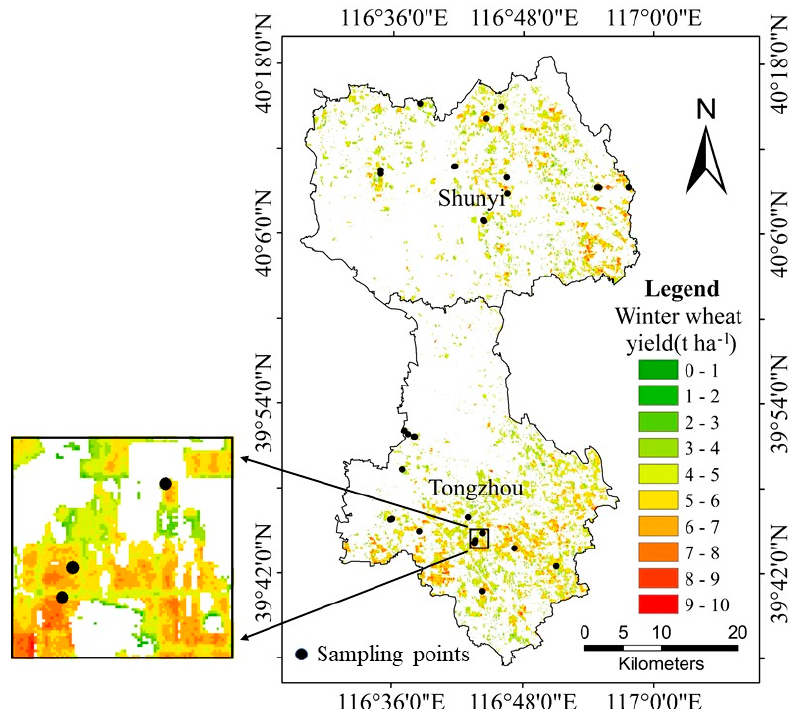
Figure 8. Spatial distribution of estimated winter wheat yield for the 2008–2009 growing season.